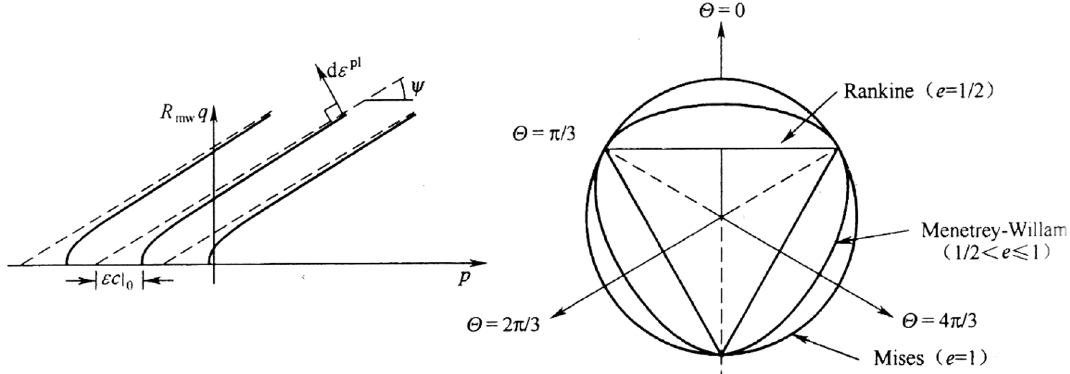
Figure 4. Flow potential of Mohr–Coulomb strength